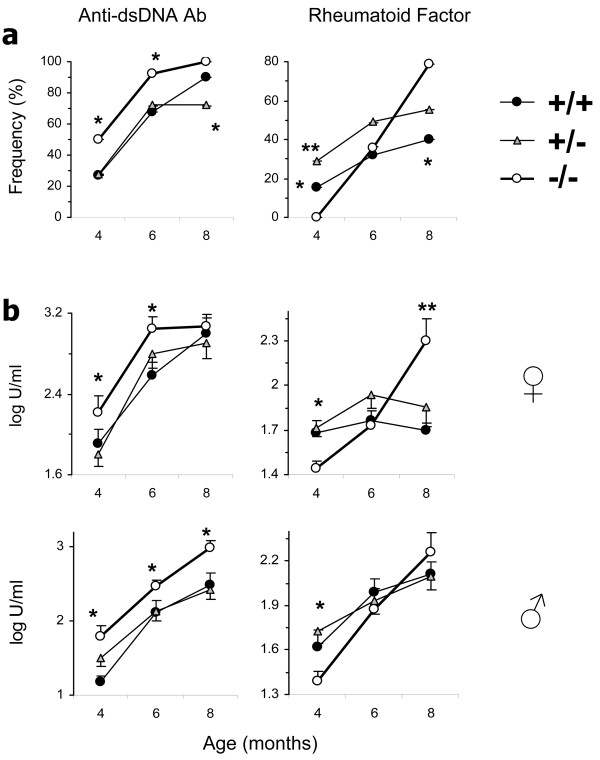
Serum anti-dsDNA autoantibodies and rheumatoid factor (RF) are increased in β2 microglobulin-deficient (β2m°) BWF1 mice. β2m+/+ (n = 18 female and 12 male, closed circles), β2m+/- (n = 30 female and 28 male, triangles), and β2m-/- (n = 11 female and 10 male, open circles) mice were bled and serum samples tested for IgG anti-dsDNA antibody and RF. (a) Results are expressed as the percent of mice with autoantibodies, using a cutoff level of the mean + 4 SD optical density (OD) value in sera from six normal age-matched BALB/c mice. Results pooled from male and female mice are shown (*P <0.05, **P <0.01; Fisher's exact test). (b) Results of autoantibodies are shown as the mean ± standard error of log U/ml in male and female mice separately (*P <0.01 to 0.05, **P <0.001, Student's t-test).